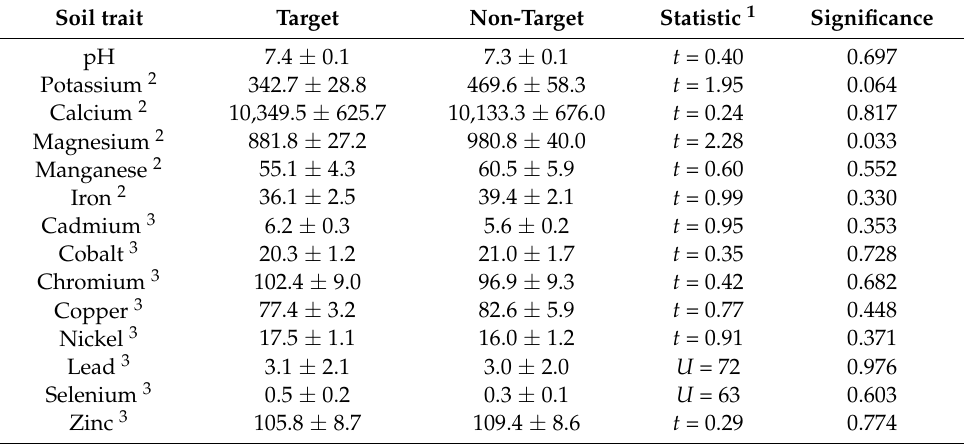
Table 1. The influence of proximity to Cycas micronesica trees on soil chemical traits in Guam cobbly clay soils on Guam. Target soils were collected underneath cycad trees. Non-target soils were collected 5-m from focal cycad trees. Means ± SE, n = 12.